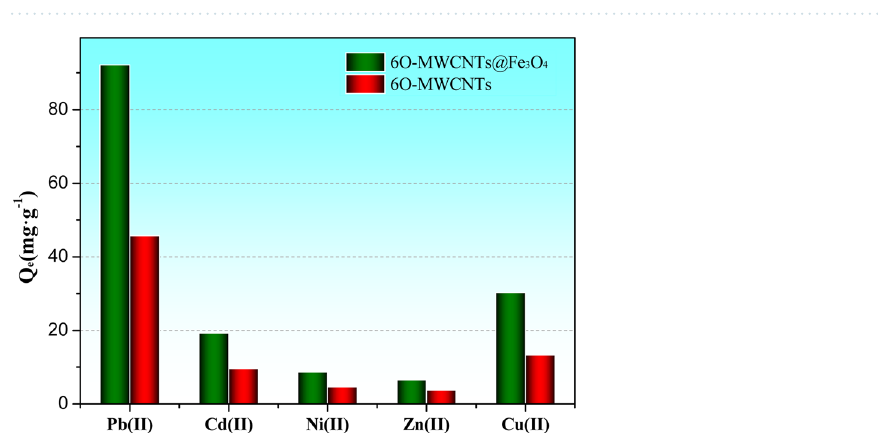
Figure 7. Effect of adsorption time on the adsorption performance of 6O-MWCNTs ( a ) and 6O-MWCNTs@ Fe